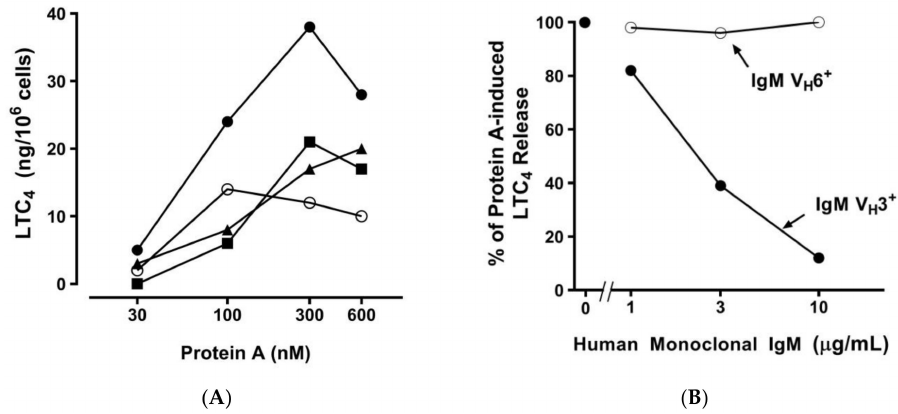
Figure 3. ( A ) E ff ect of increasing concentrations of protein A on the de novo synthesis of cysteinyl leukotriene C 4 (LTC 4 ) from four di ff erent preparations of HHMCs. HHMCs were incubated (45 min at 37 ◦ C) with the indicated concentrations of protein A. Each point shows the mean of duplicate determinations. Each symbol represents the results from an individual donor. ( B ) E ff ect of preincubation of protein A with human monoclonal IgM on the activation of HHMCs. Protein A (300 nM) was preincubated (15 min at 37 ◦ C) with increasing concentrations (1 to 10 µ g / mL) of human monoclonal IgM V H 3 + or IgM V H 6 + . HHMCs were then added and incubation continued for another 45 min at 37 ◦ C. Each point shows the mean of duplicate determinations of a representative experiment. Similar results were obtained in two other